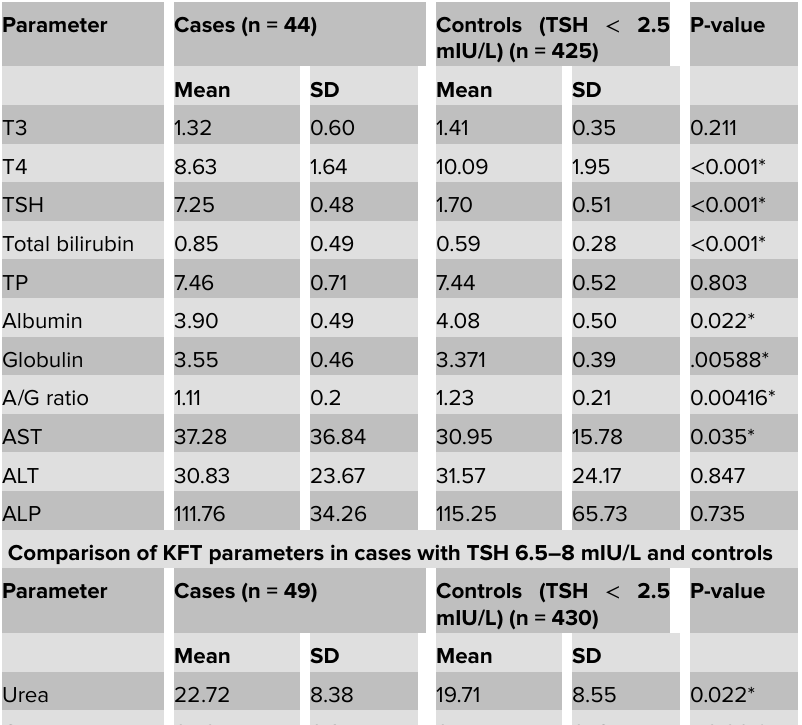
Table 4: Comparison of LFT parameters in cases with TSH 6.5–8 mIU/L and controls. Parameter